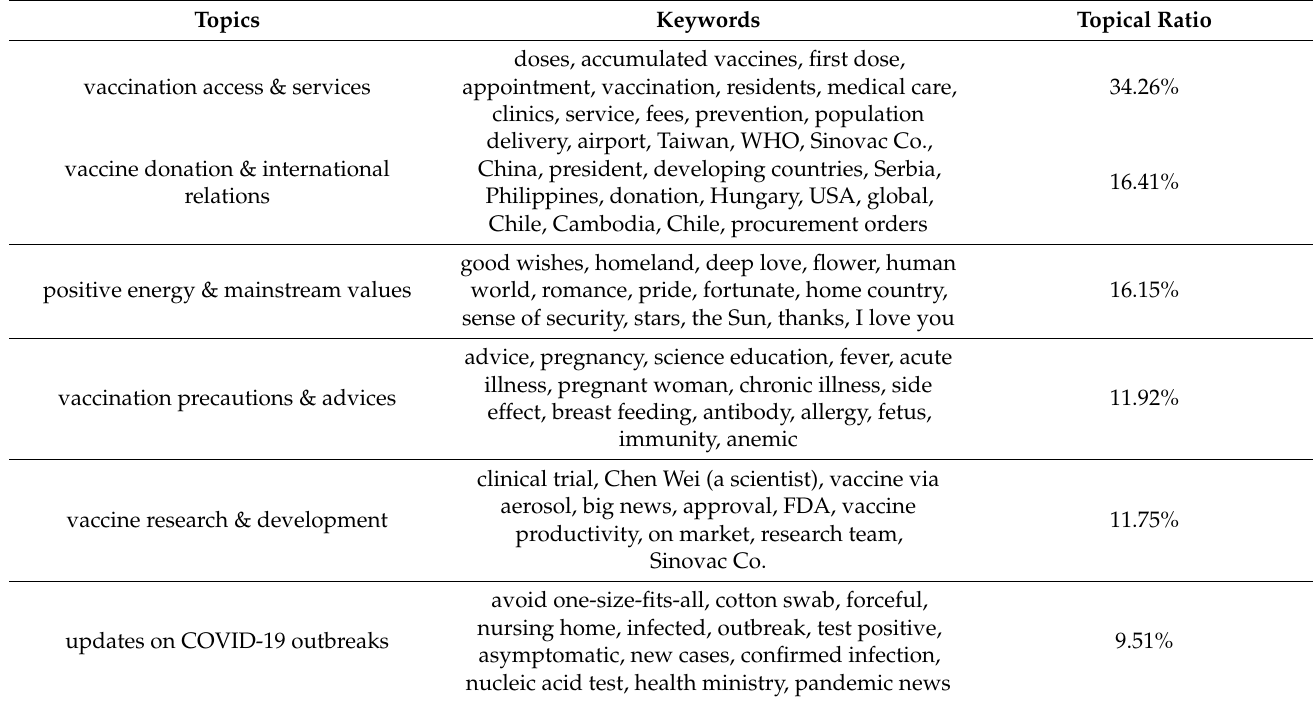
Table 1. Major topics of TikTok videos based on topic modeling.